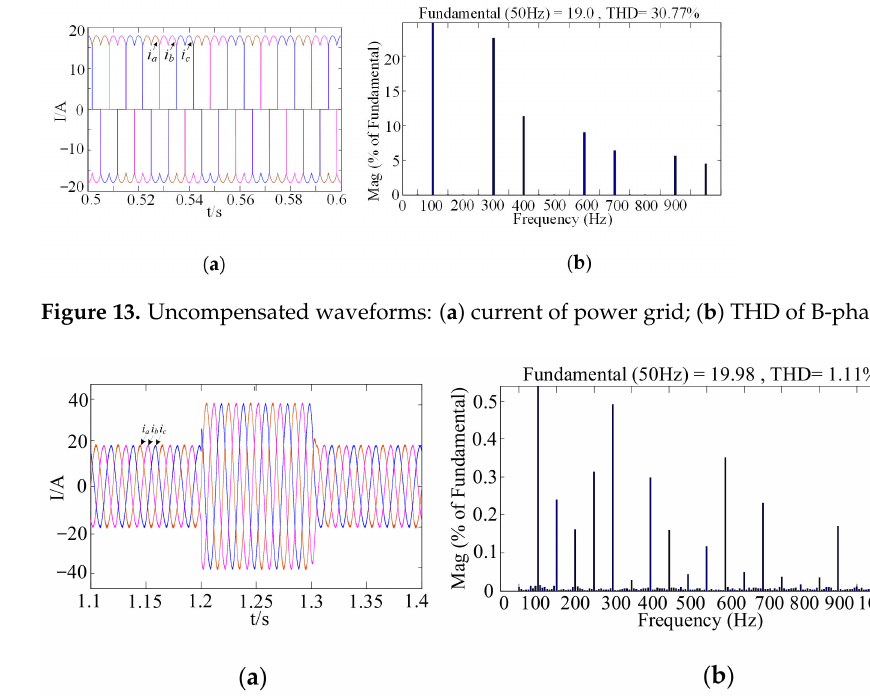
Figure 14. Compensated waveforms: ( a ) current of power grid; ( b ) THD of B-phase current.